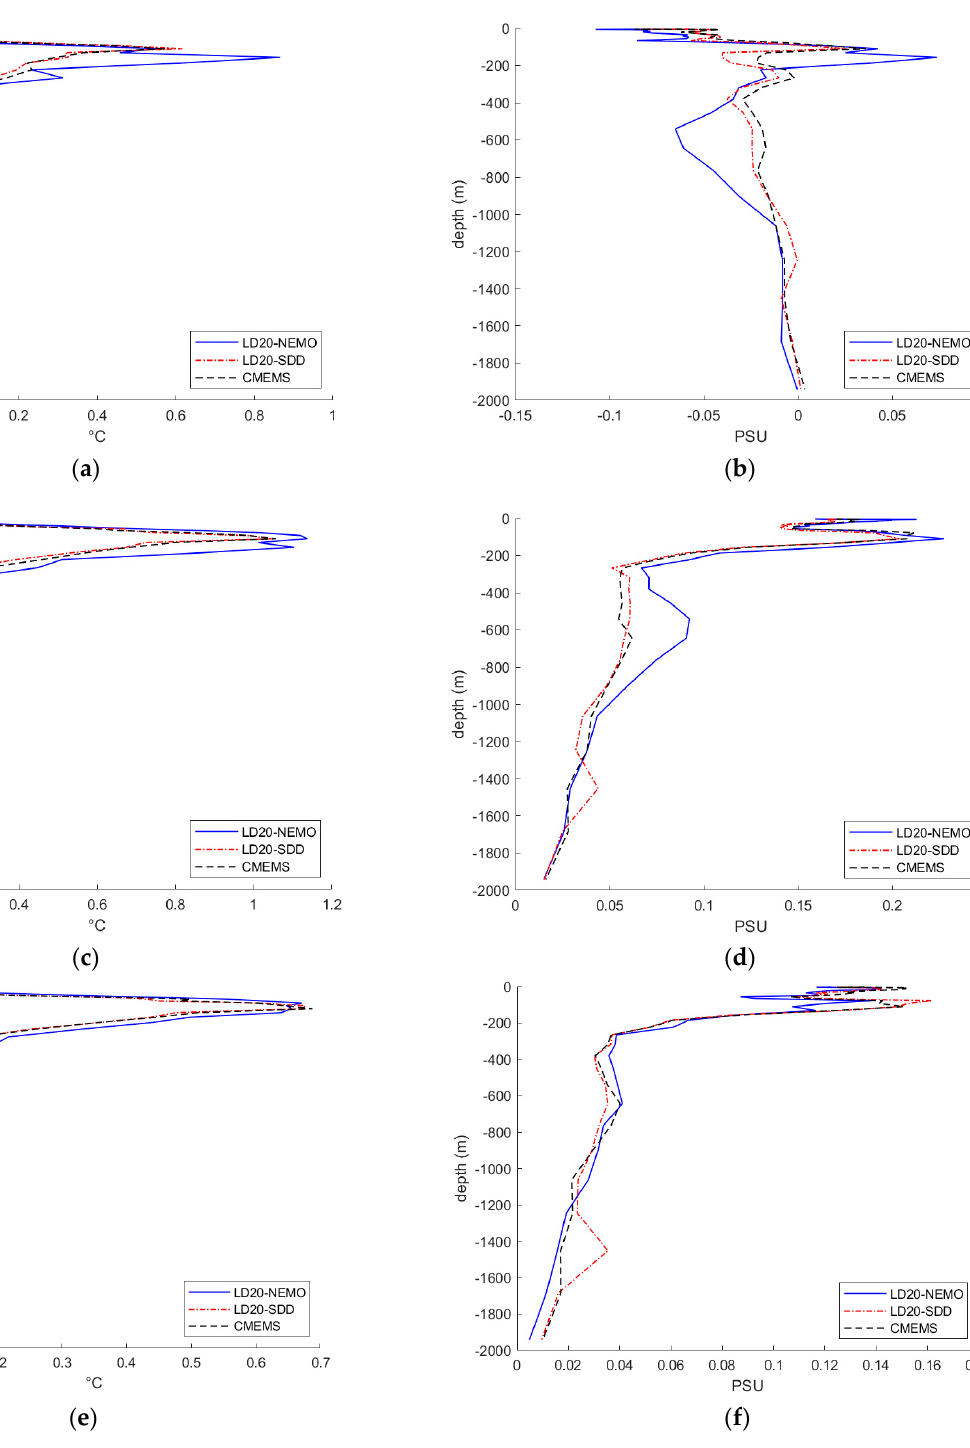
Figure 6. Comparison of temperature (left panels) and salinity (right panels) profiles from CMEMS, LD20-NEMO and LD20-SDD models, with respect to ARGO float observations: ( a , b ) Bias; ( c , d ) RMSD; ( e , f ) RMSDA. The period of averaging is from 1 January 2015 to 31 December 2018. The ability of a model to resolve smaller scale features can be assessed by analysing the simulated fields of relative vorticity. Vorticity is an important characteristic of the mesoscale and sub-mesoscale dynamics of the ocean and is a powerful tool to analyse ocean dynamics [4]. Vorticity is calculated using derivatives of current velocity, and hence an overly-smoothed representation of velocity will result in an underestimation of vorti- city. Figure 7 shows a snapshot of the surface velocity and vorticity fields produced by CMEMS at 1/12°, as well as LD20-NEMO and LD20-SDD at 1/20°. The date in Figure 7 was selected among the hundreds of thousands of computed maps, as representative of a period of low mesoscale activity, so that the number of eddies was relatively small and they were clearly seen on the maps. ( a )